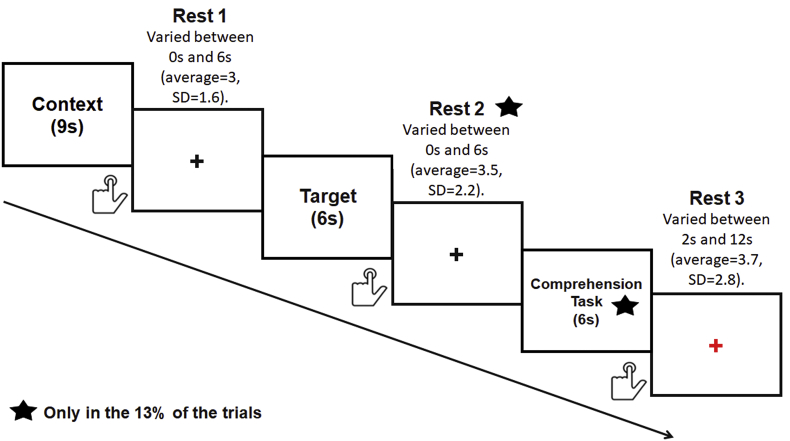
Schematic depiction of trial structure and timing.